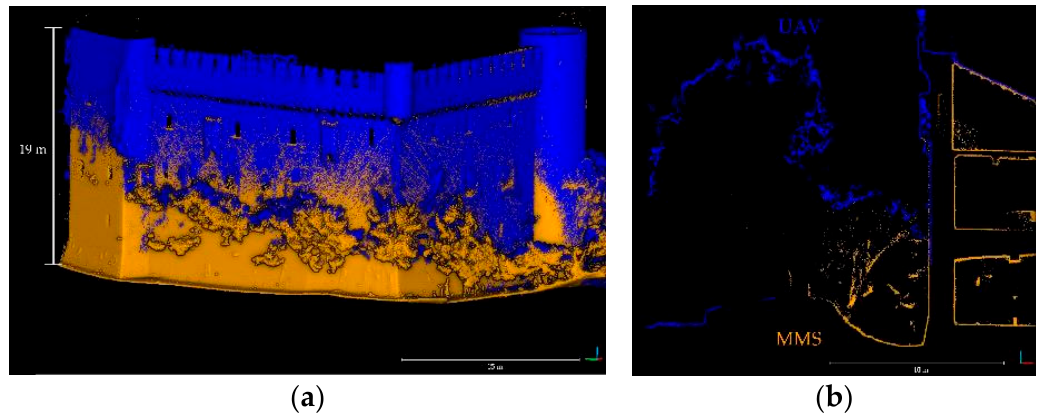
Figure 12. Extension of point clouds, UAV data coloured in blue, ZEB data in orange: ( a ) angular view of the external walls with the presence of vegetation and ( b ) vertical section of the Rocca.